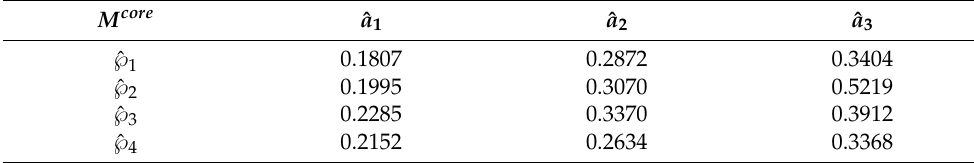
Table 12. Tabular formation of core matrix M core .